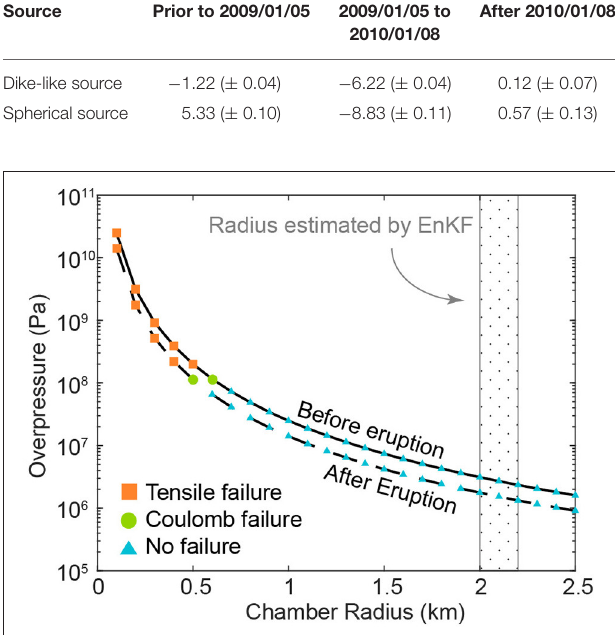
TABLE 3 | Flux rates ( × 10 5 m 3 /yr) of the sources from the EnKF data assimilation.